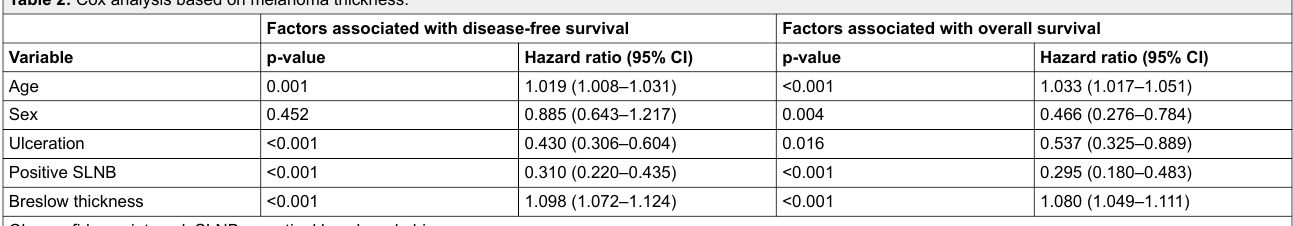
Table 2: Cox analysis based on melanoma thickness. Factors associated with disease-free survival Factors associated with overall